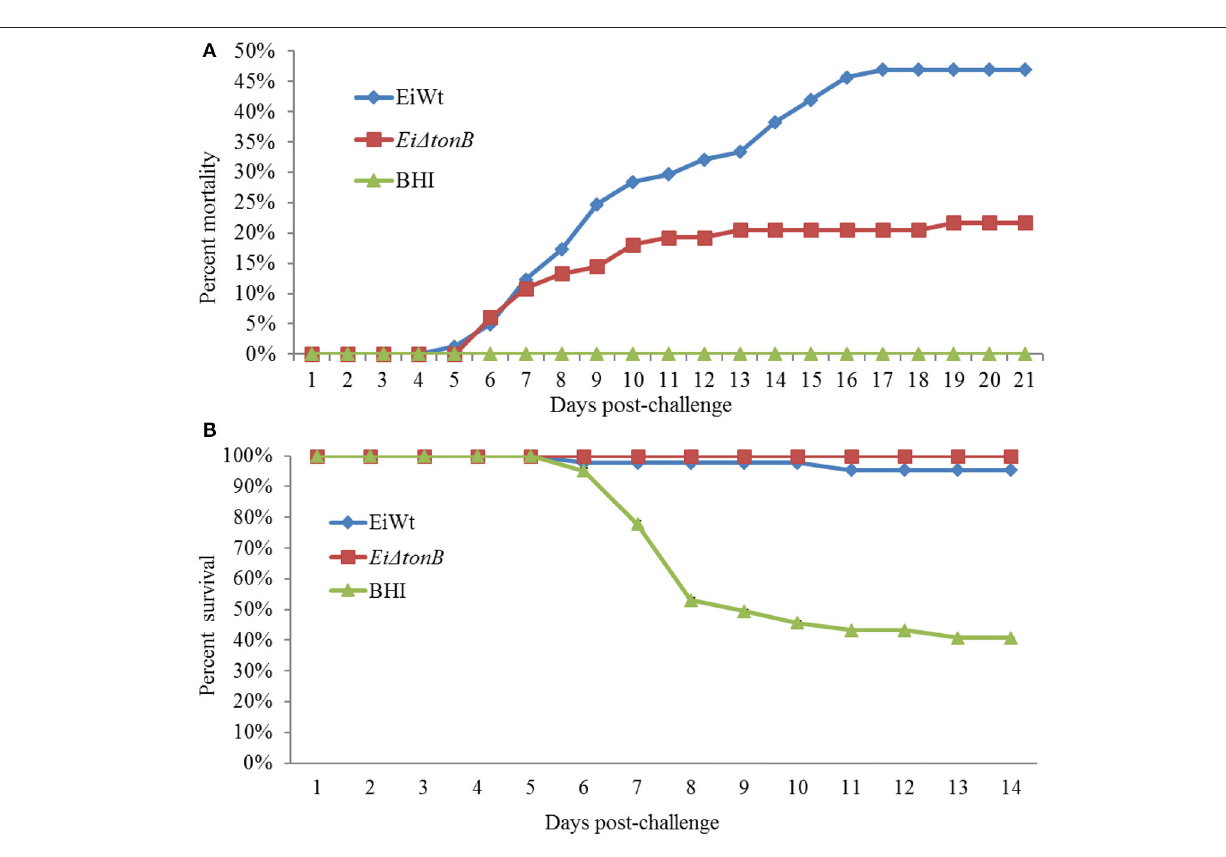
EIB202 TonB (81% identity), which is in agreement with species phylogeny. The goal of the current research was to elucidate the role of E. ictaluri TonB in iron acquisition and